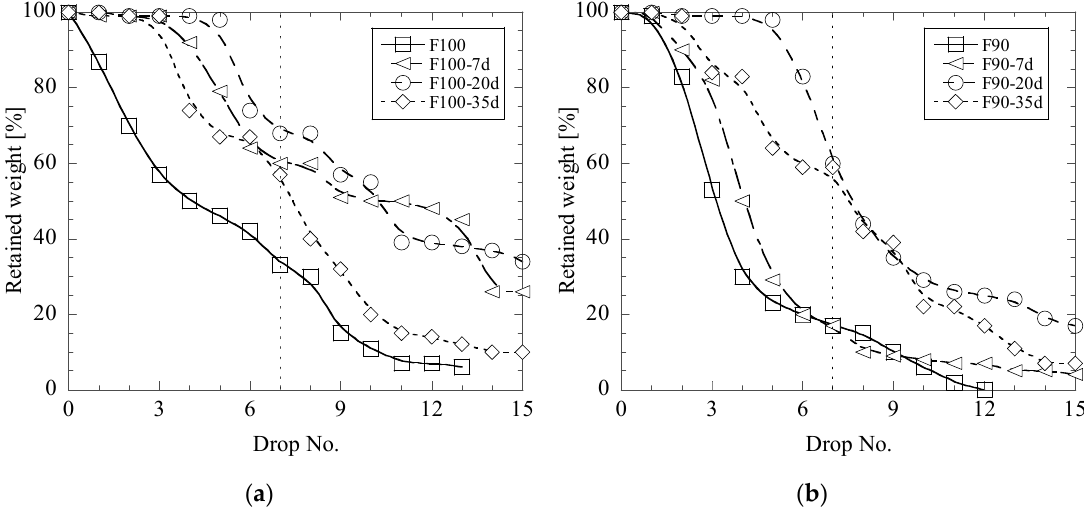
Figure 4. Effect of storage of briquettes F100 ( a ) and F90 ( b ) in air on the retained weight during drop test trials.